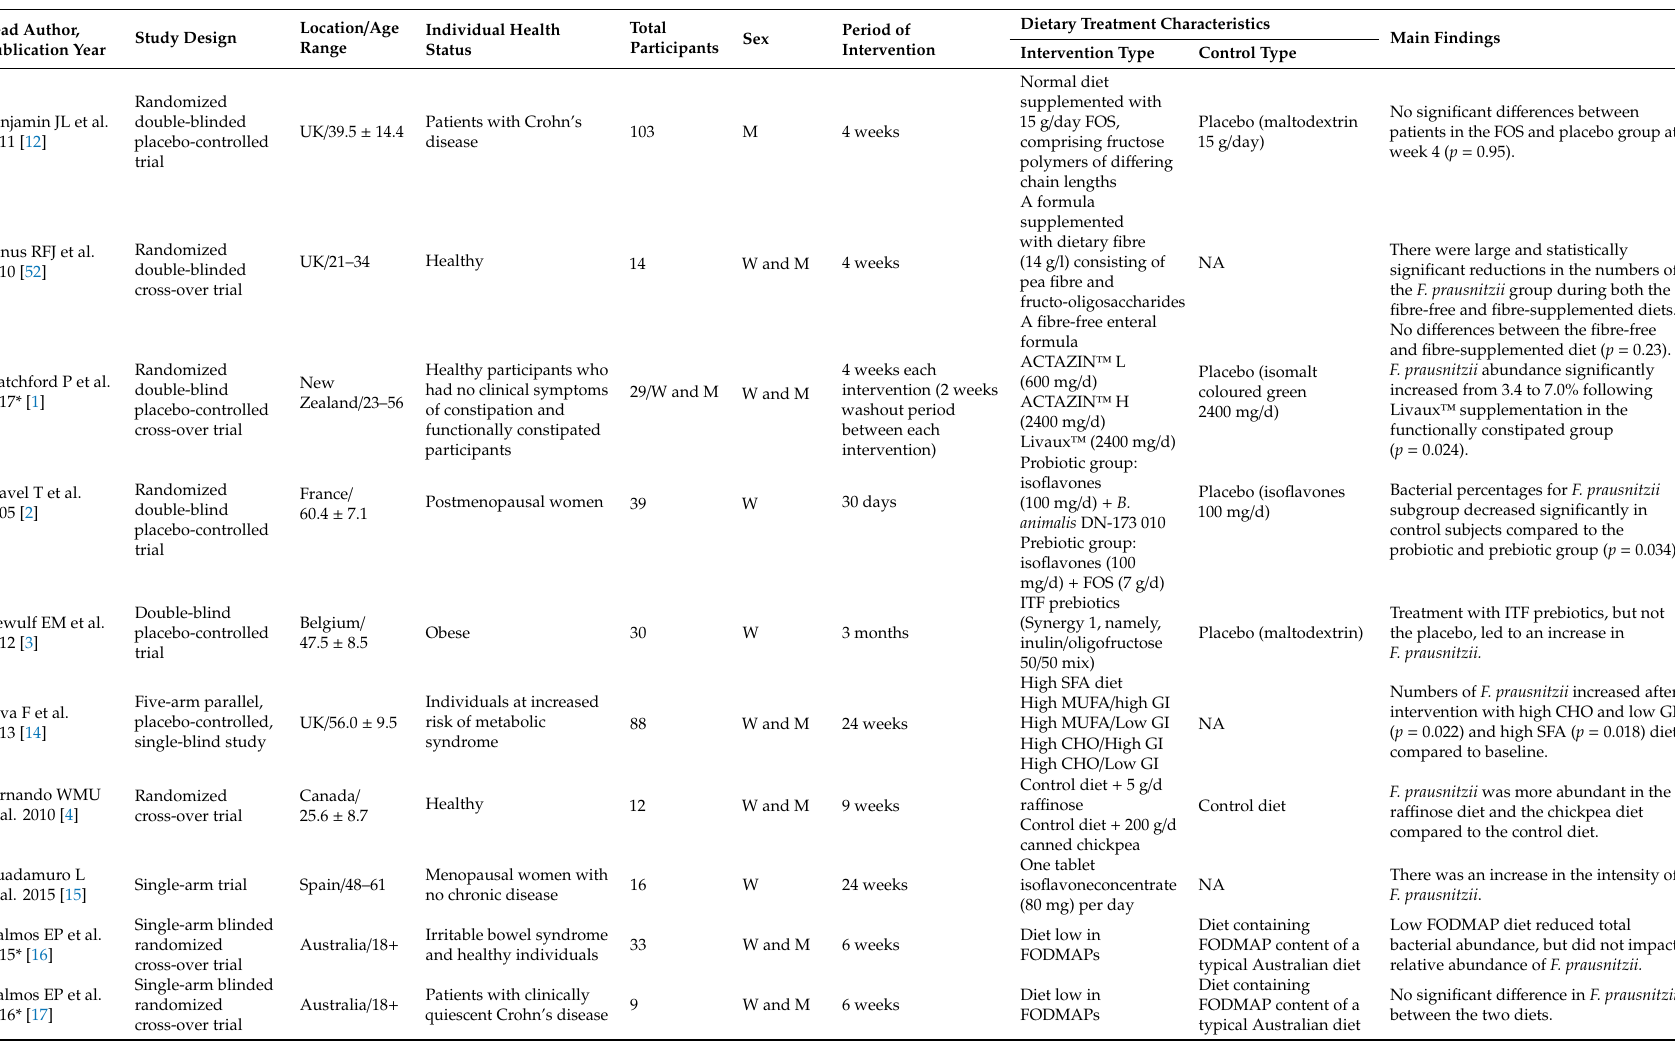
Table 2. Descriptive Summary of Randomized Clinical Trials Investigating the Associations Between Dietary Interventions and Faecalibacterium